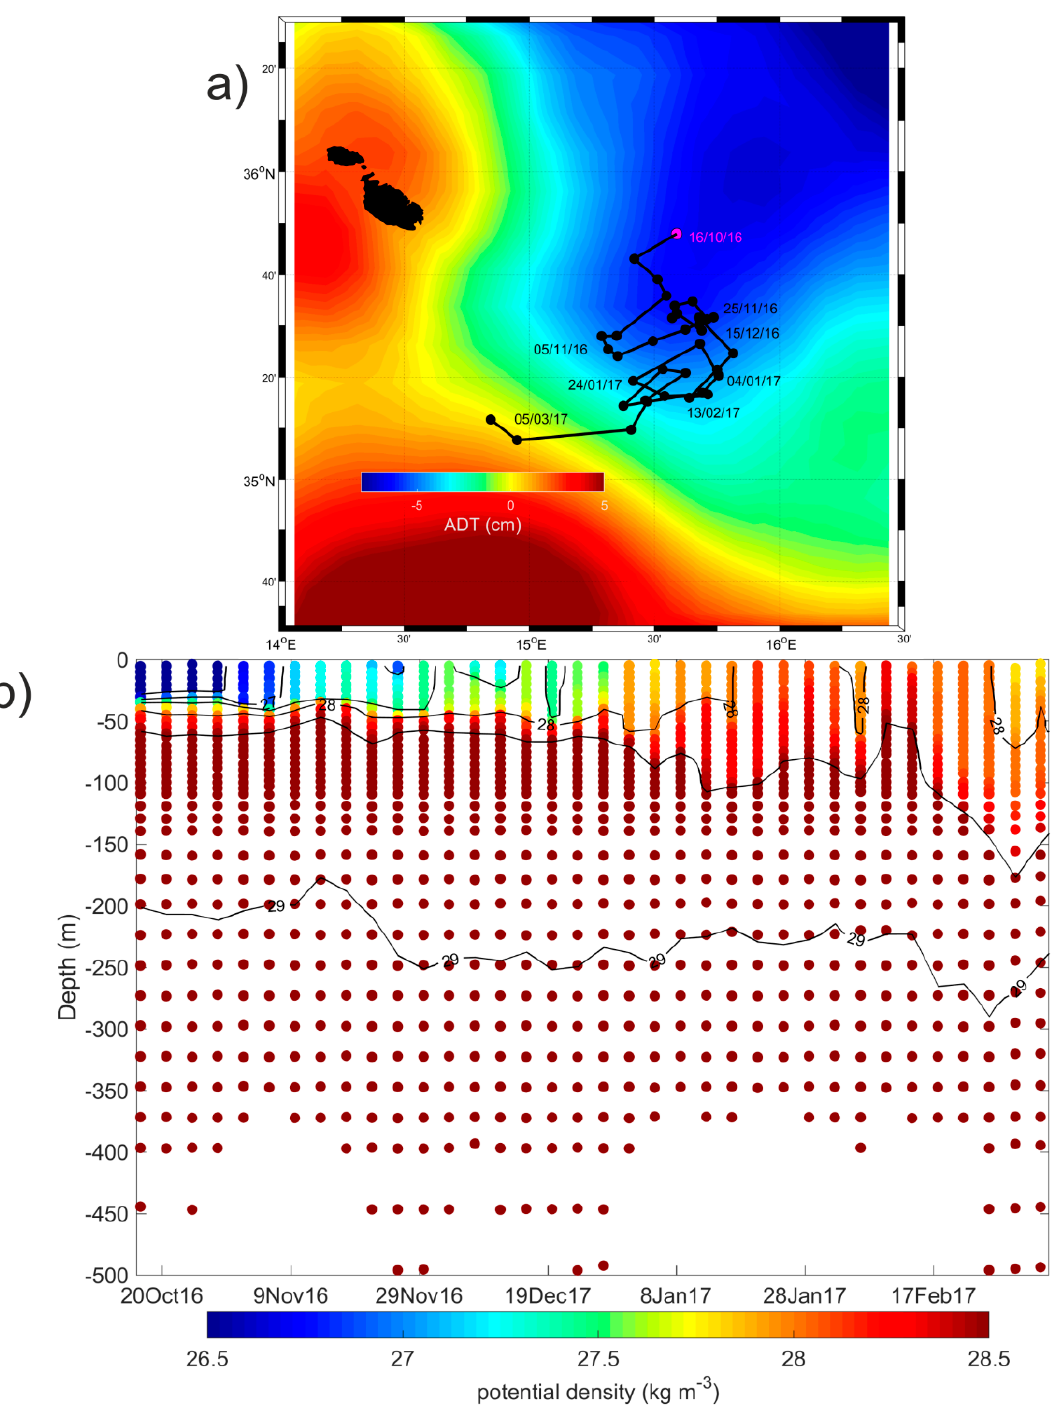
Figure 16. Map of the trajectory (black line) and profile positions (First profile: Magenta dot; Other profiles: Black dots) of the float WMO 1,900,954, superimposed on the mean map of the ADT (between 20 October 2016 and 7 March 2017) ( a ) and contour diagram of the potential density versus depth and time ( b ).